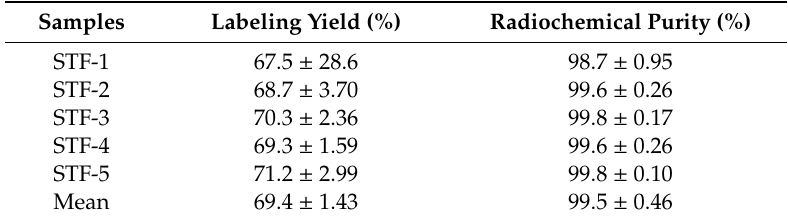
Table 1. Labeling yield and radiochemical purity of 89 Zr-labeled STF-1 to 5 after purification. Stationary